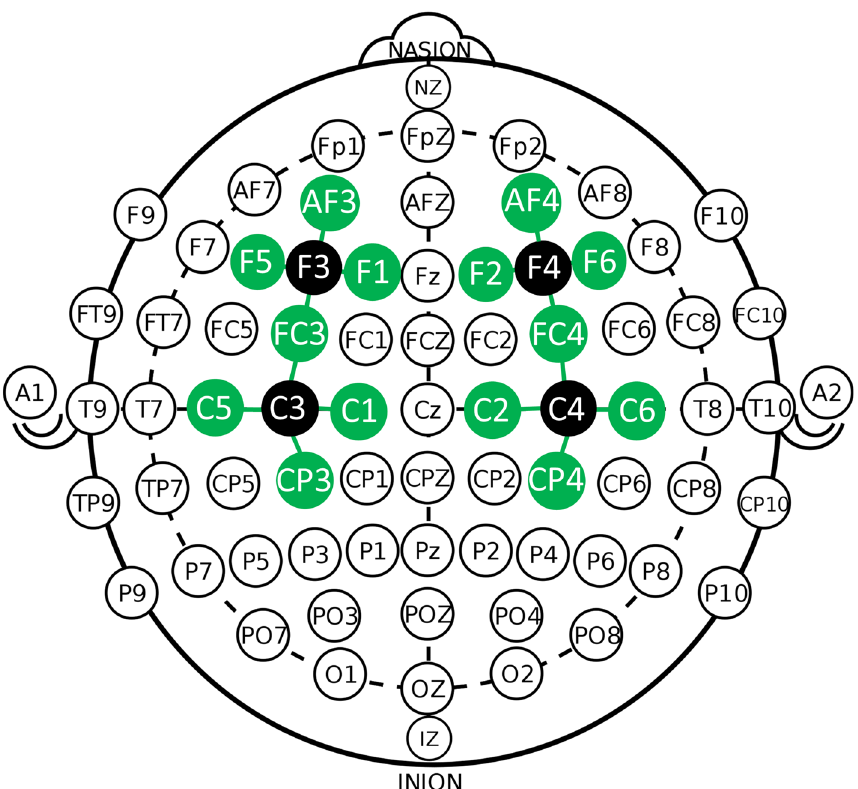
Figure 1. fNIRS montage. fNIRS functional near-infrared